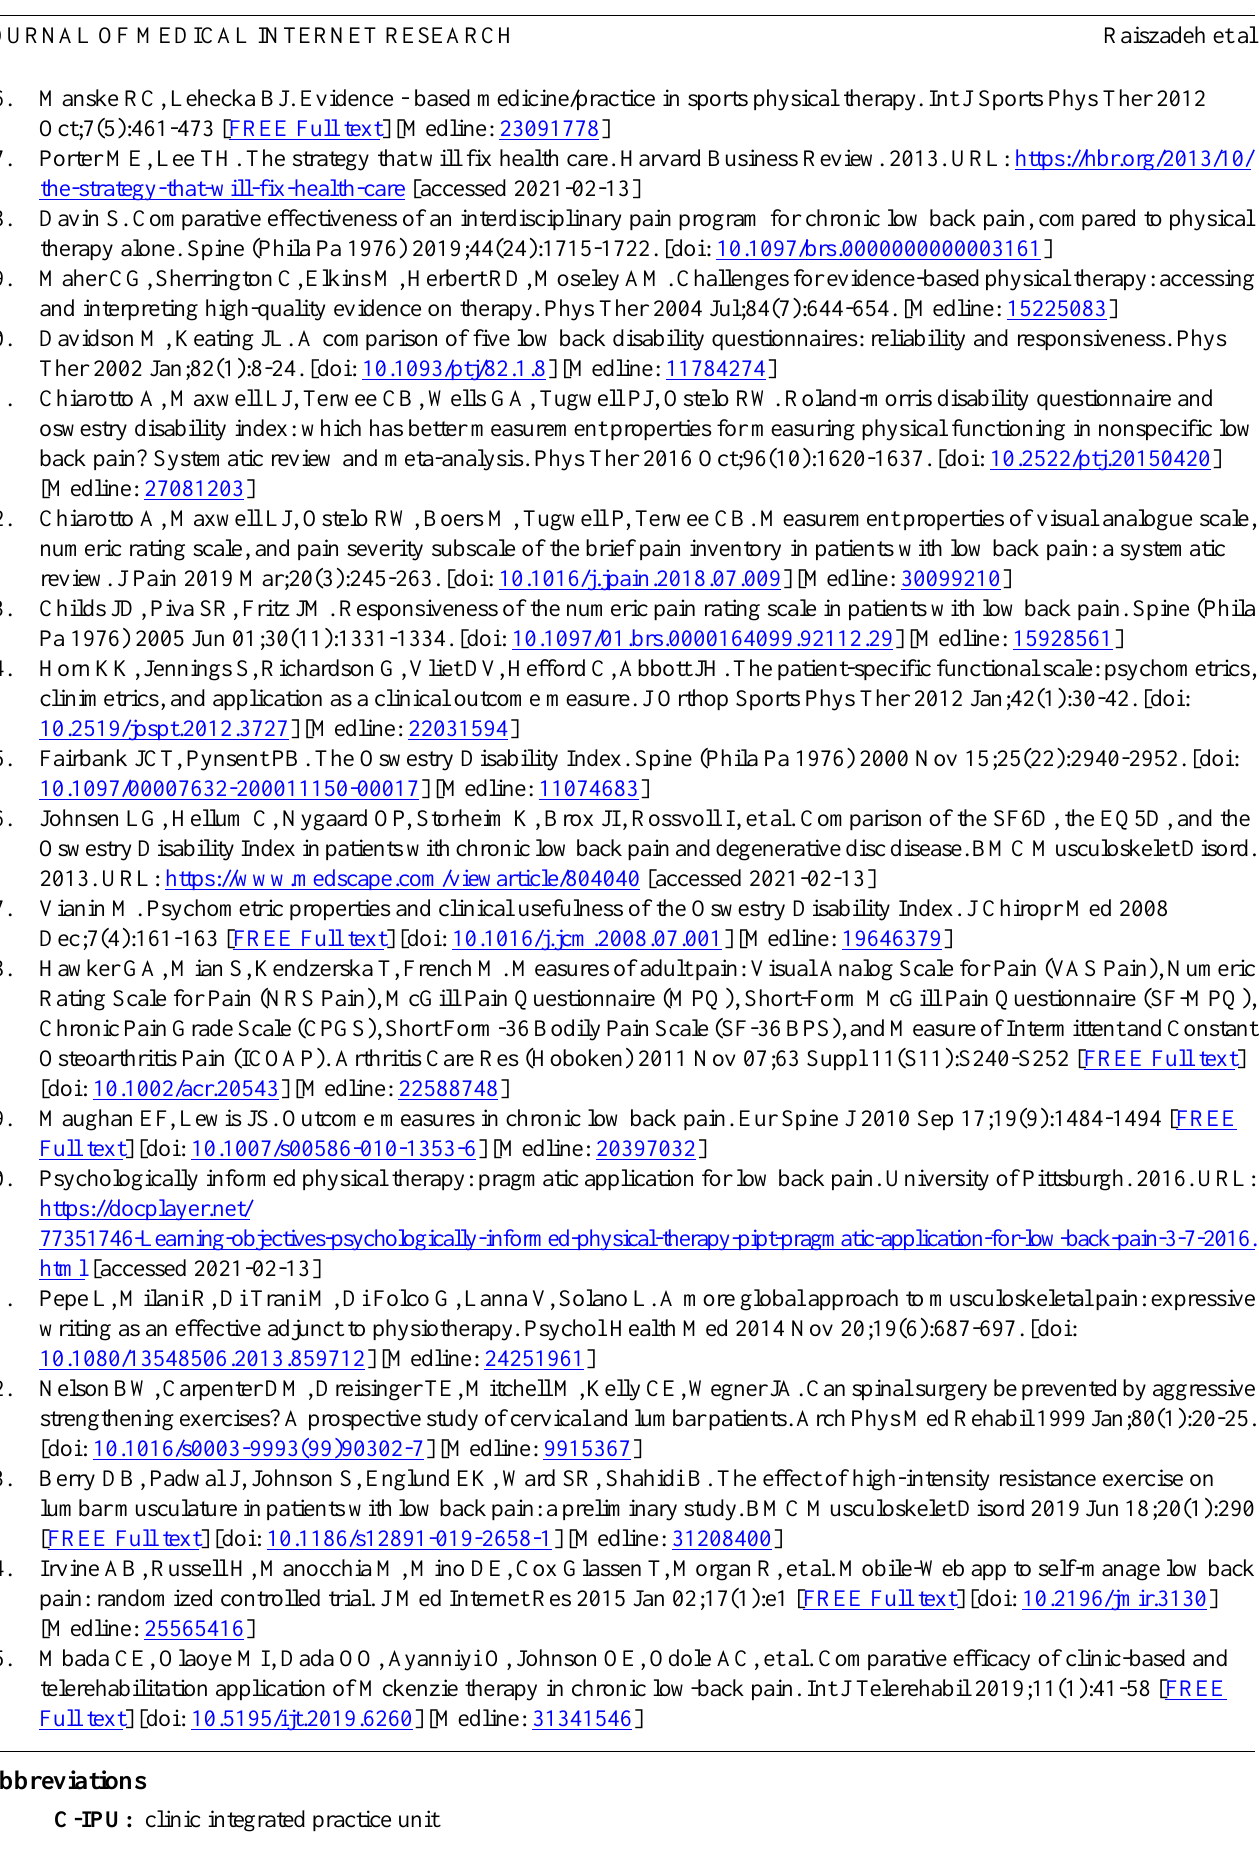
C-IPU: clinic integrated practice